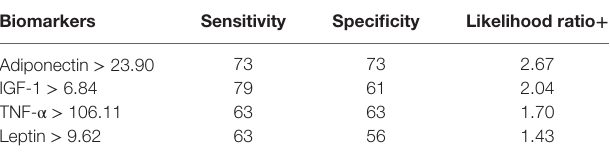
TaBle 5 | Discriminative power of serum biomarkers based on optimum cut point.